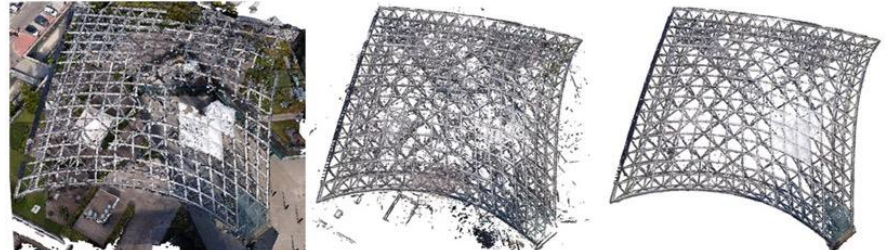
Figure 28. Prediction of the classification on the test set of some flights of all of the attempts made.